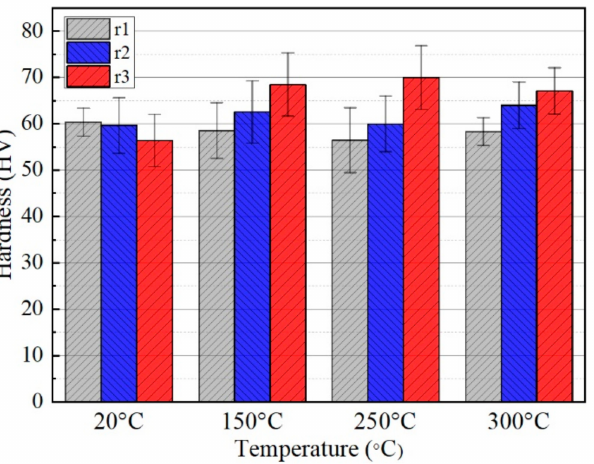
Figure 12. Average microhardness of specimens in the transverse section of different regions at different